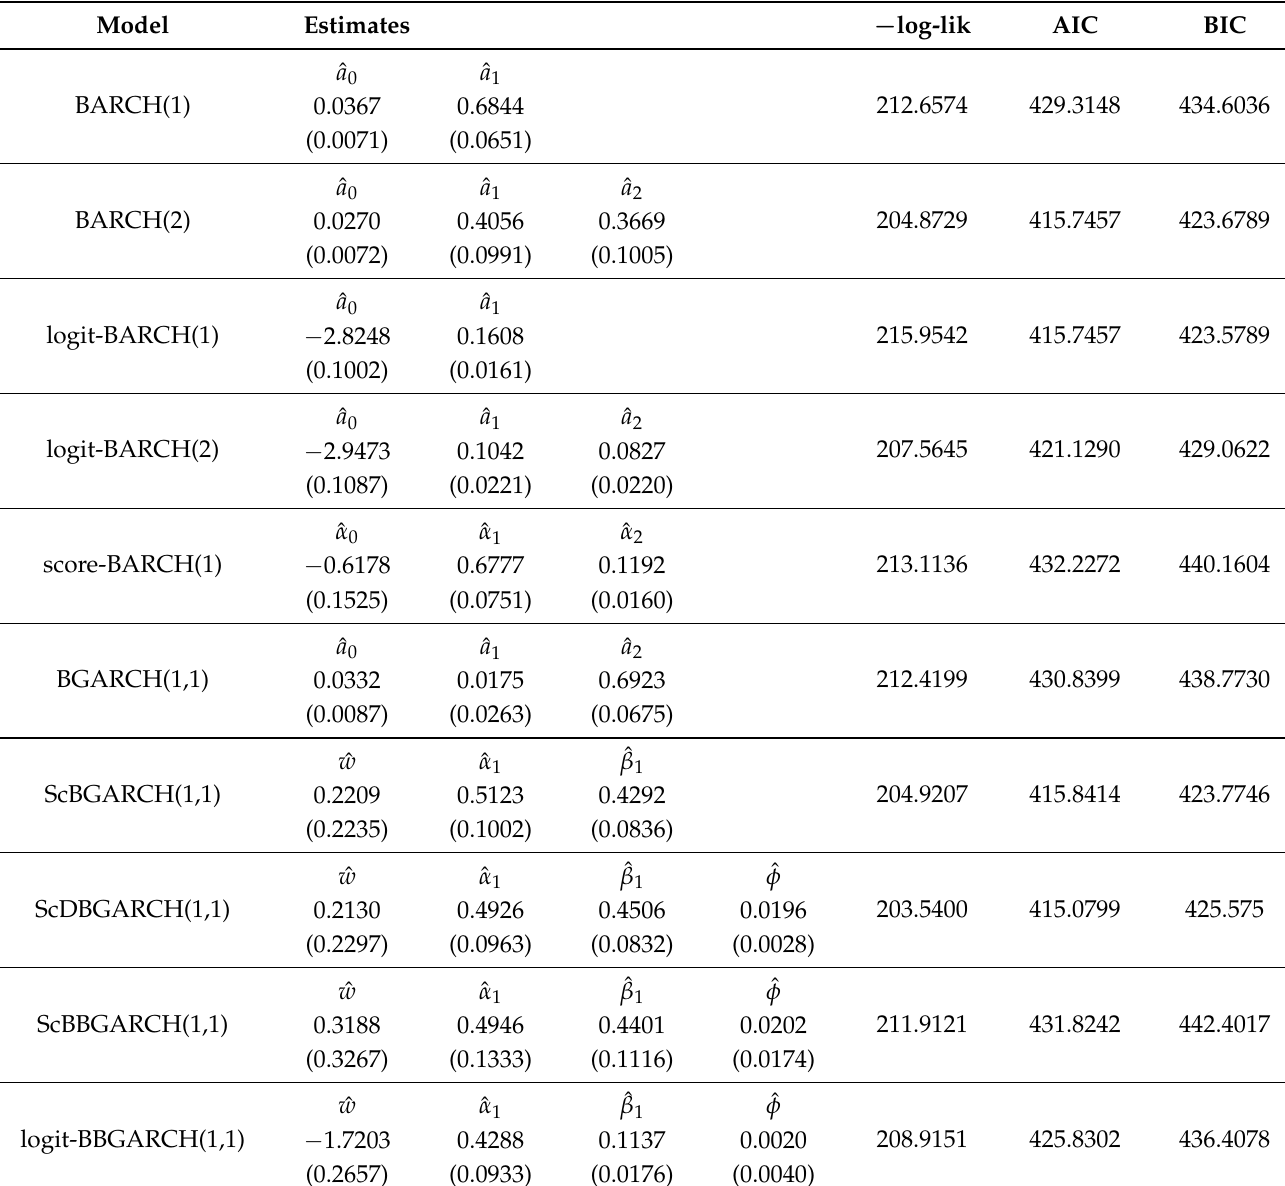
Table 1. Estimates and SEs in parentheses for the measles infection counts.